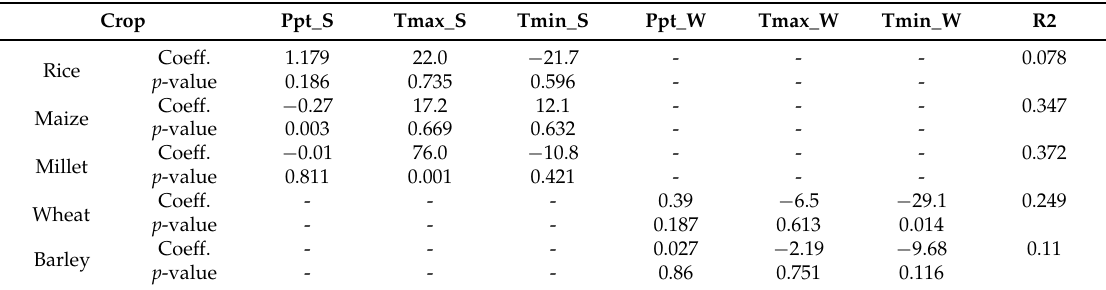
Table 6. Multivariate regression analyses of detrended crop yields.